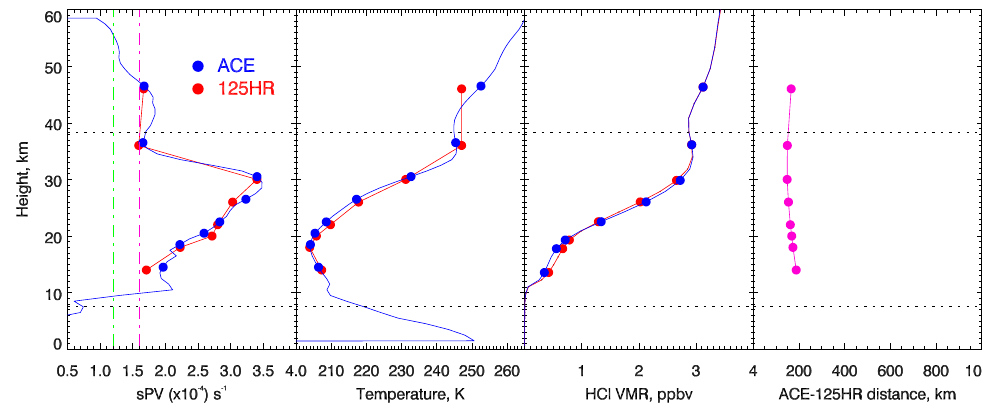
Fig. 7. Sample plots for determining the comparability of ACE-FTS and 125HR measurements. Plots from left to right show (a) the sPV (with inner and outer edge of the vortex marked with magenta and green dashed lines respectively), (b) temperature, (c) HCl VMR profile (where the ACE-FTS profile has been smoothed to match the 125HR), and (d) distance between ACE-FTS and 125HR measurements, with data being determined from DMPs along the lines-of-sight of each instrument. Dotted lines indicate the altitude range for the partial column used in this comparison. ACE-FTS information is shown in blue, and 125HR is shown in red. This example shows a well-matched comparison between HCl measurements made on the 13 March 2007. The difference in the 9.82–38.40km partial columns is 1.4%.